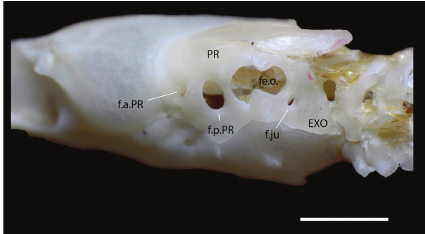
Figure 9: Lateral view of the posterior part of the skull of Sordellina punctata (IBSP 49404). Bar = 2 mm. Abbreviations other than in previous figures: f.a.PR: anterior foramen of prootic; f.ju: jugular foramen; f.p.PR: posterior foramen of prootic; fe.o: fenestra